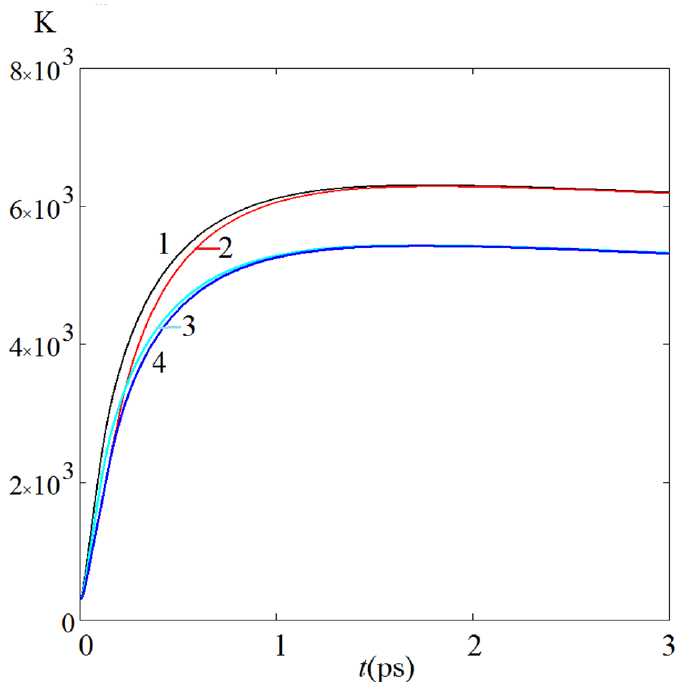
Figure 11. Kinetics of electron temperature when varying the power density of the irradiating pulse in the range PS = 50 MW/cm 2 (curve 1) − 250 MW/cm 2 (curve 5), fixed laser pulse duration tp = 100 fs, isothermal boundary condition.